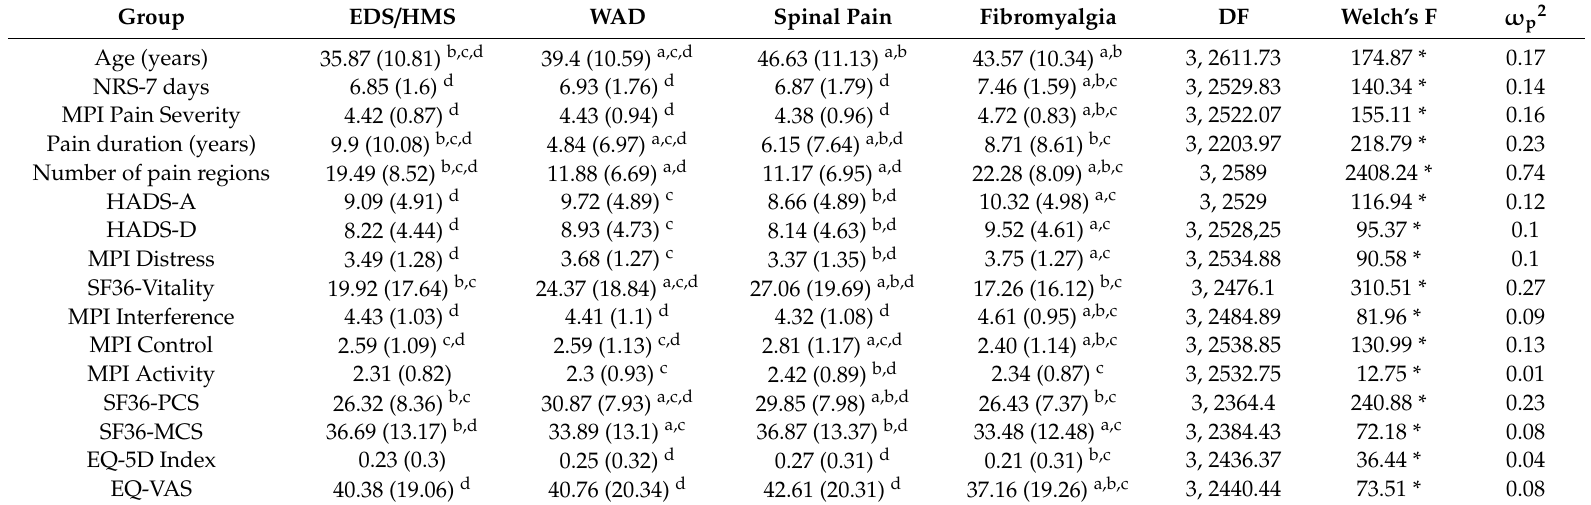
Table 4. Mean values (and one standard deviation) for the Patient Reported Outcome Measures (continuous variables) in the four groups of patients. The results of the one-way ANOVAs comparing the four groups (i.e., DF, Welch’s F, and ω p2 ) are to the